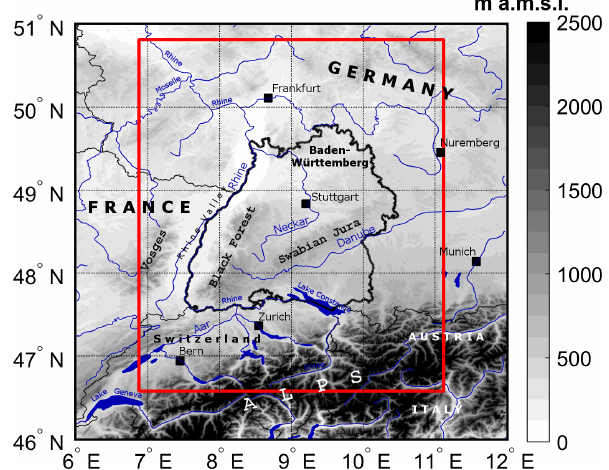
Figure 1. Topographic map (in meters above mean sea level; ma.m.s.l.) of southwestern Germany and surrounding areas with main river networks and lakes as well as substantial orographic structures. The national borders (slim solid black contours) and the border of the federal state of Baden-Württemberg (bold solid black contour) are shown, as well as the model domain (red box), which extends from 46.6 to 50.8 ◦ N and from 6.9 to 11.1 ◦